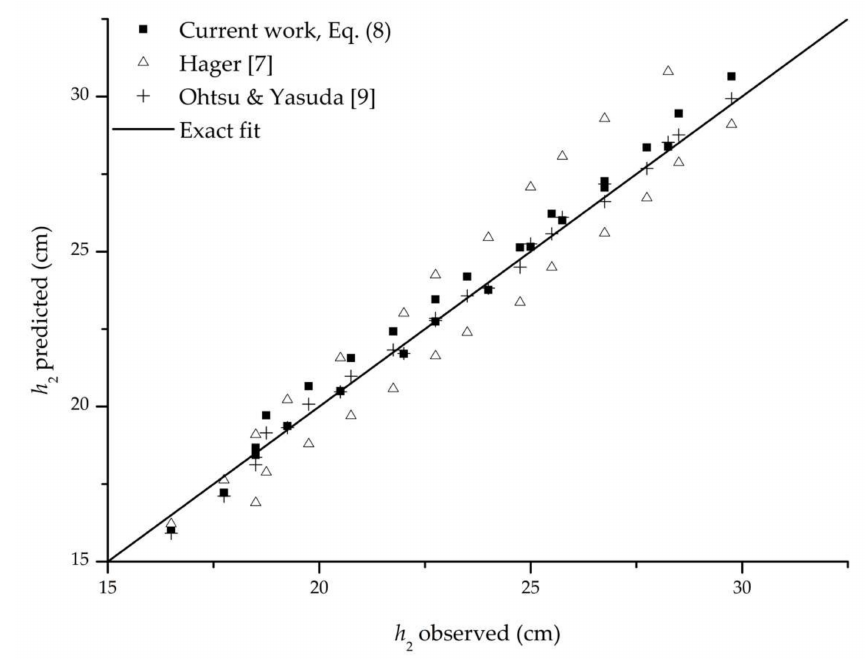
Figure 11. Comparison of different methods for predicting downstream depth h 2 for B